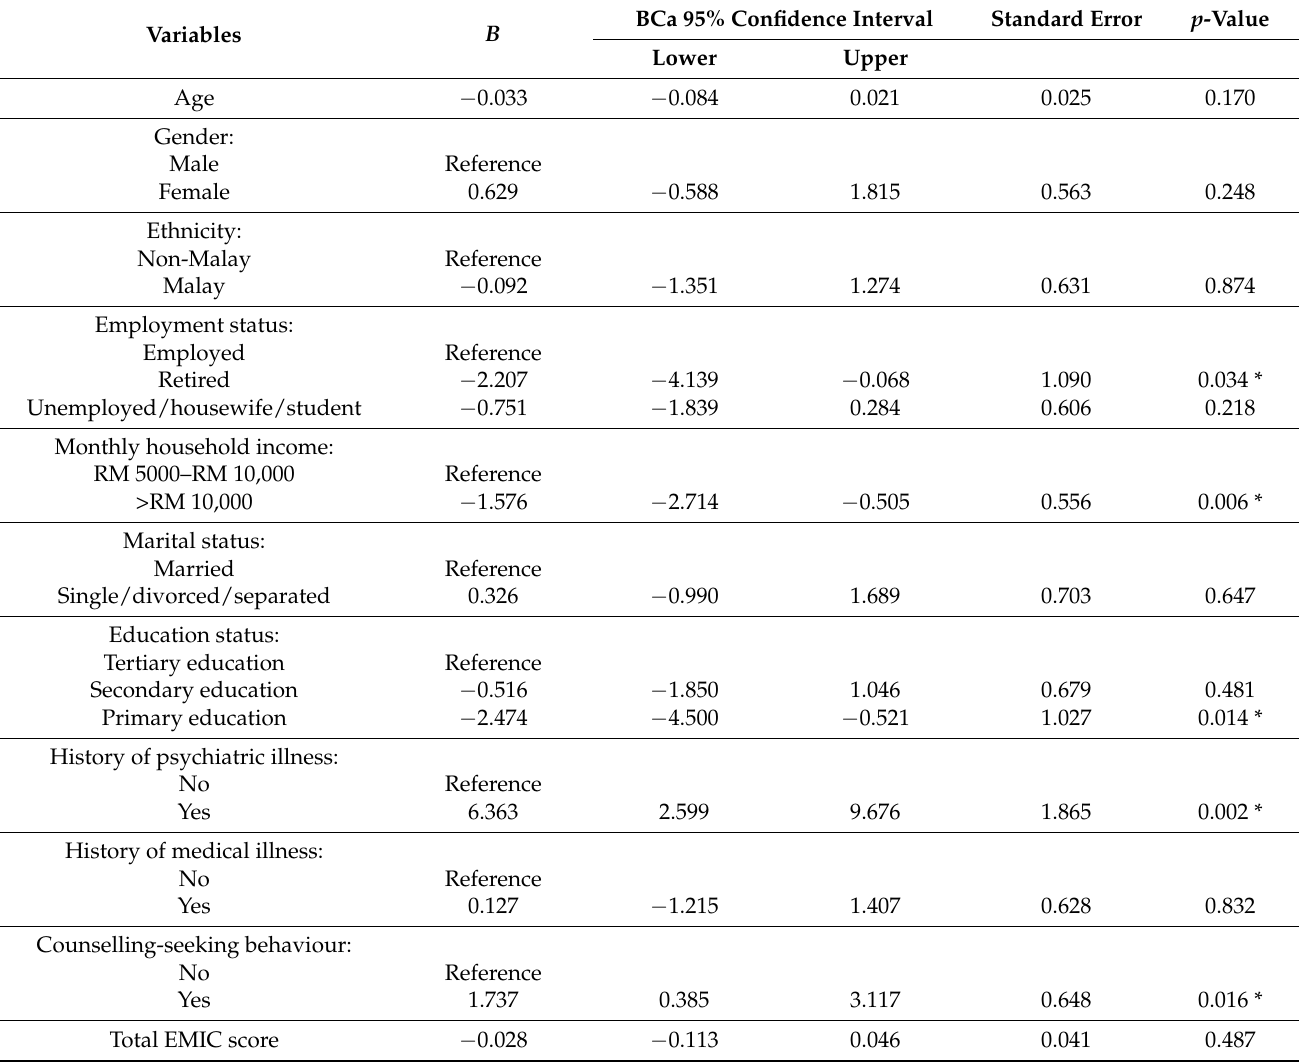
Table 2. Multivariate general regression model with bootstrapping with 2000 replications for socio- demographic and clinical characteristics, perceived stigma, and severity of psychological distress among COVID-19 patients after one month of being discharged from the